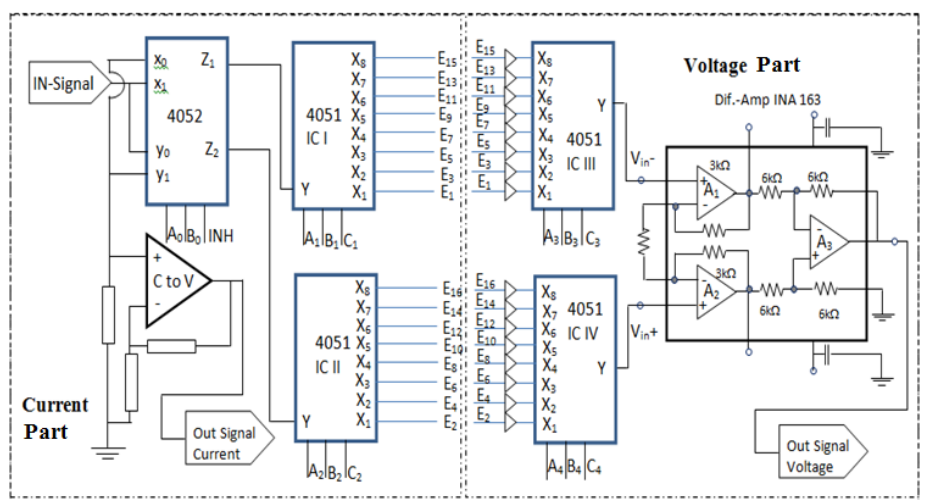
Figure 6. The electric mechanism for selecting a current injector electrode and measuring voltage.